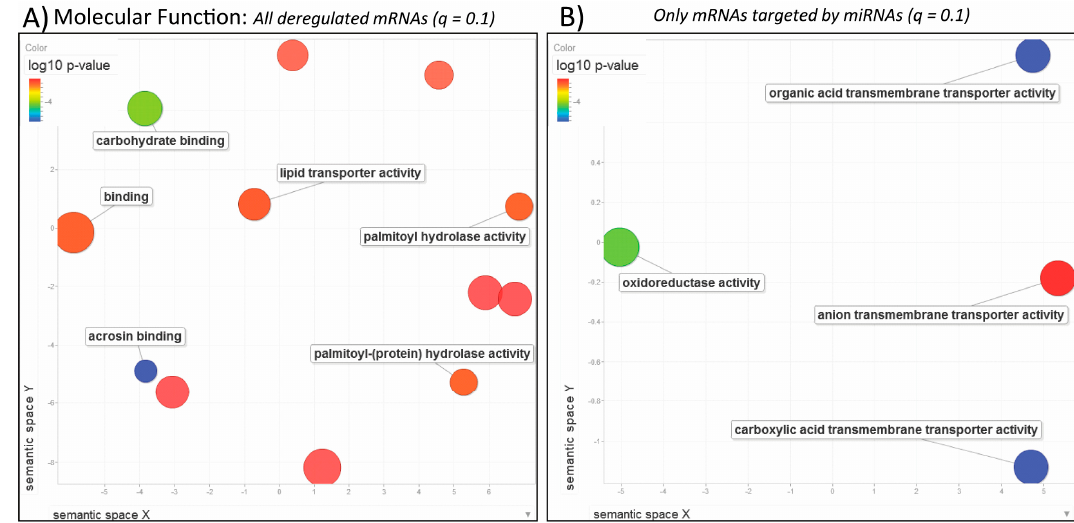
Figure 4. Molecular Function. REViGO scatterplots showing categories in 2D space for ( A ) all deregulated mRNAs obtained from DESeq2 (q ≤ 0.1) and ( B ) mRNAs that are predicted targets of the miRNAs identified by miRNA ‐ Seq (q ≤ 0.1). Blue and green bubbles are GO terms with more significant p ‐ values than the orange and red bubbles. Only the most significant terms are labeled, i.e., acrosin binding and carboxylic acid transmembrane transporter activity. Closeness on the plot reflects semantic similarities between GO terms. Bubbles of more general terms are larger.